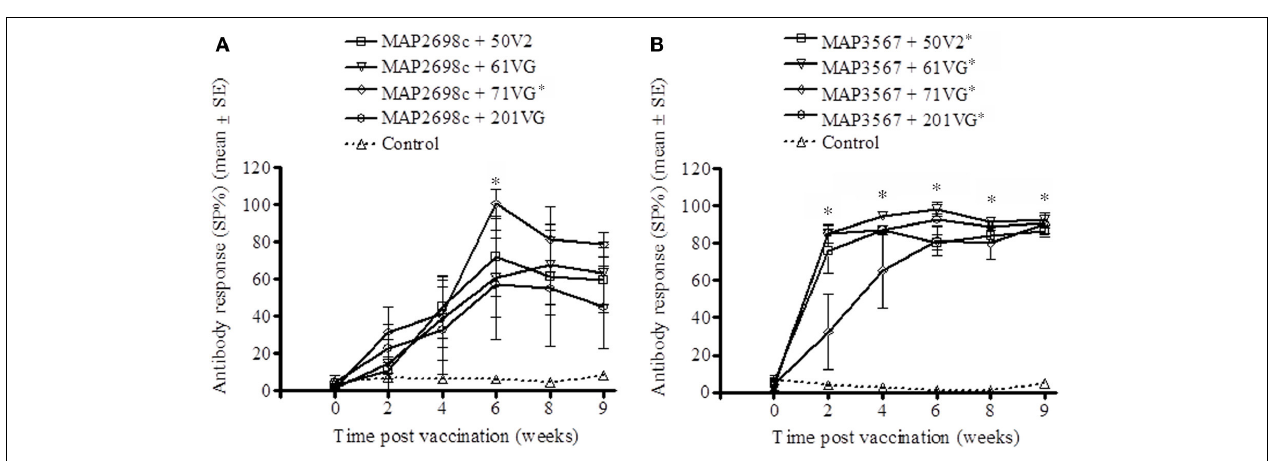
FIGURE 4 | Vaccine antigen specific antibody responses of serum from sheep vaccinated with the different formulations of recombinant antigen vaccines. (A) MAP2698c-specific antibody responses in sheep